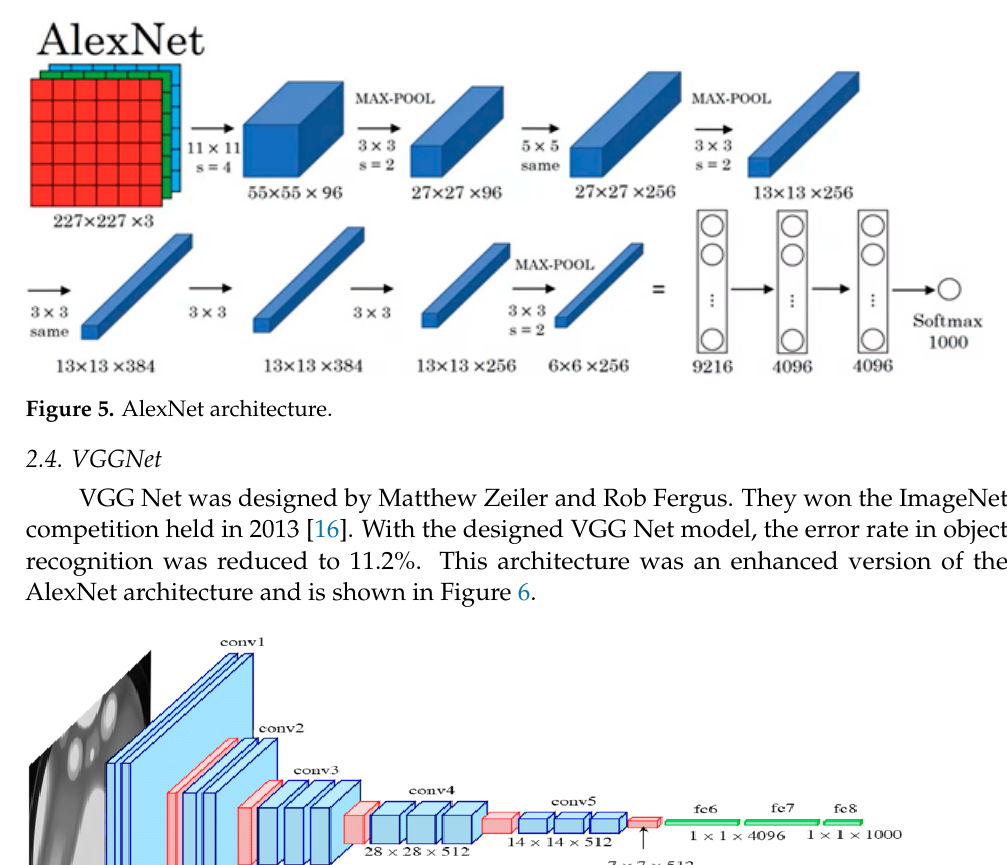
Figure 4. Architecture of a convolutional neural network.